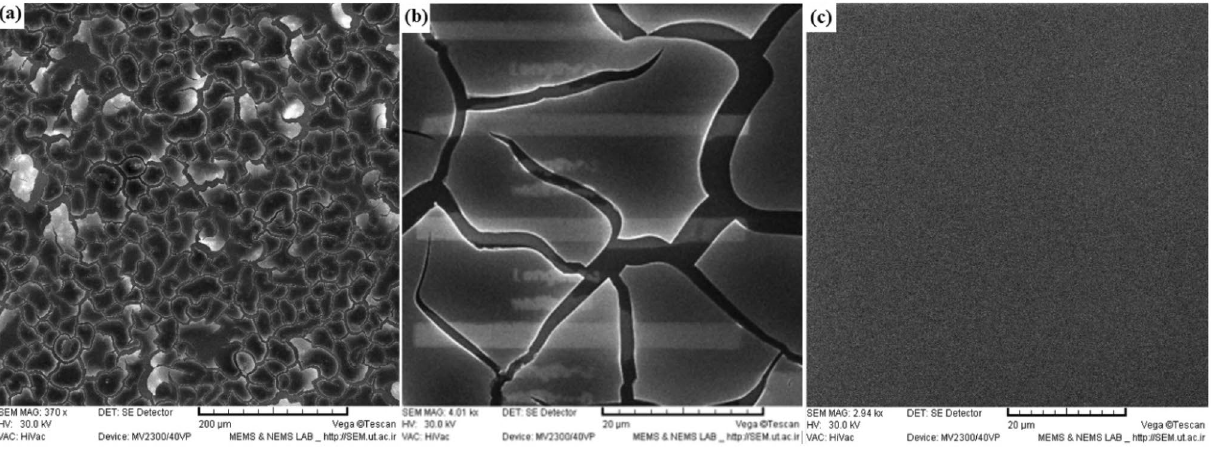
Fig. 5 SEM images of the Er: Yb doped SiO deposited layers by spin coating and annealing in scale 2